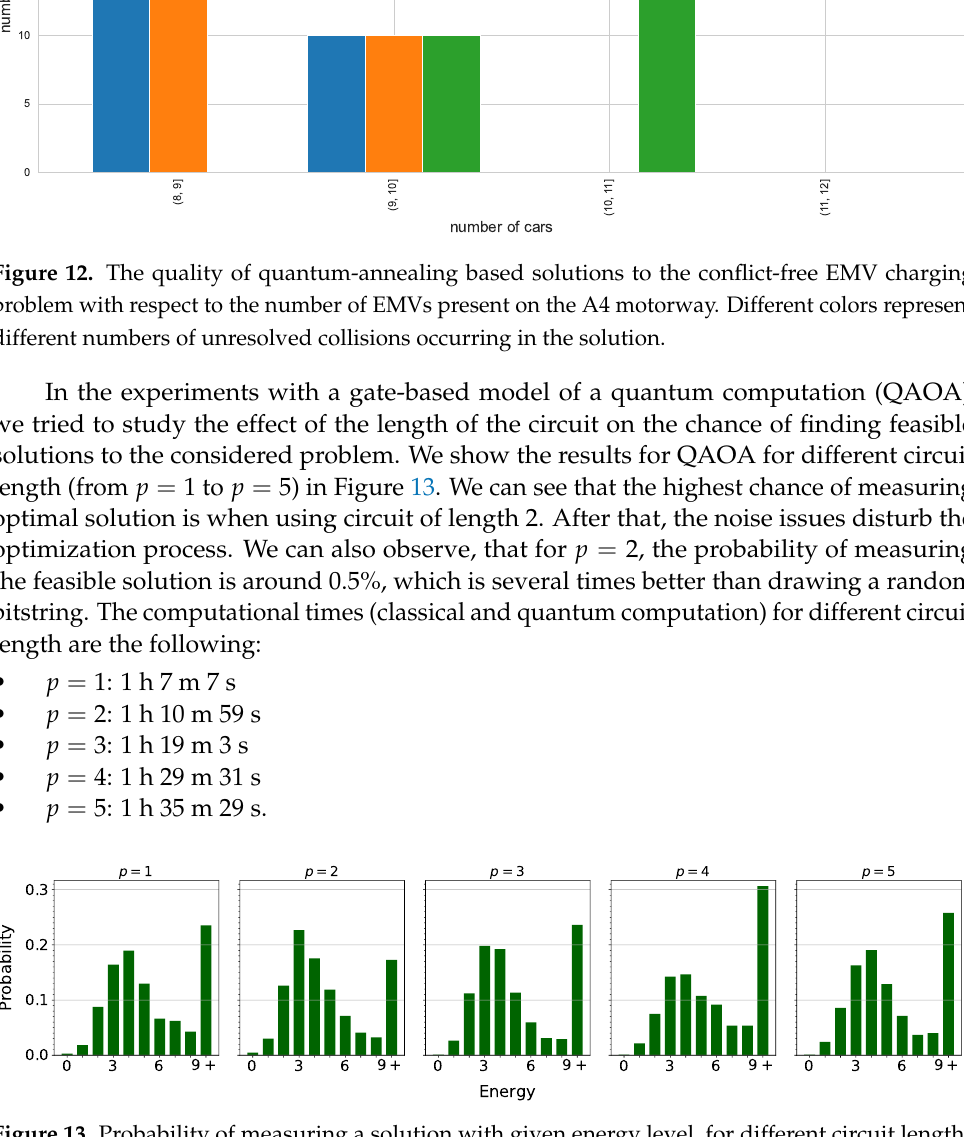
Figure 13. Probability of measuring a solution with given energy level, for different circuit lengths using QAOA